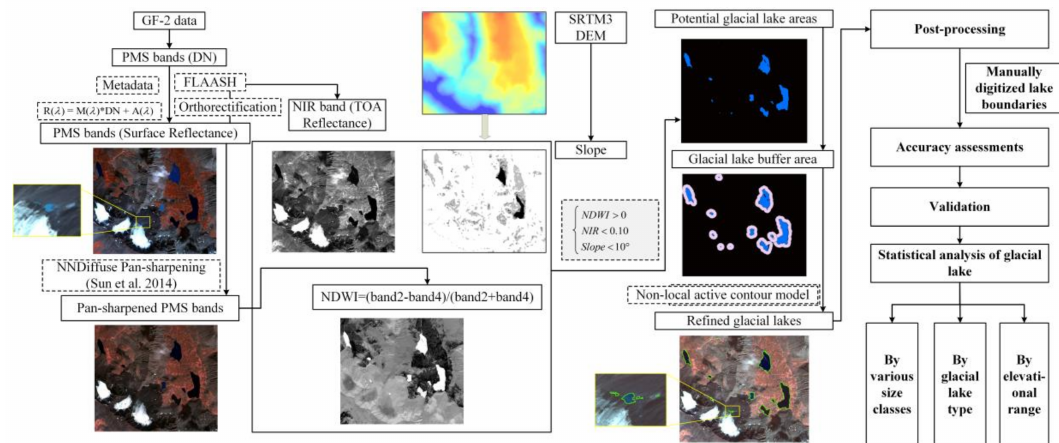
Figure 2. Workflow of the proposed method for glacial lake